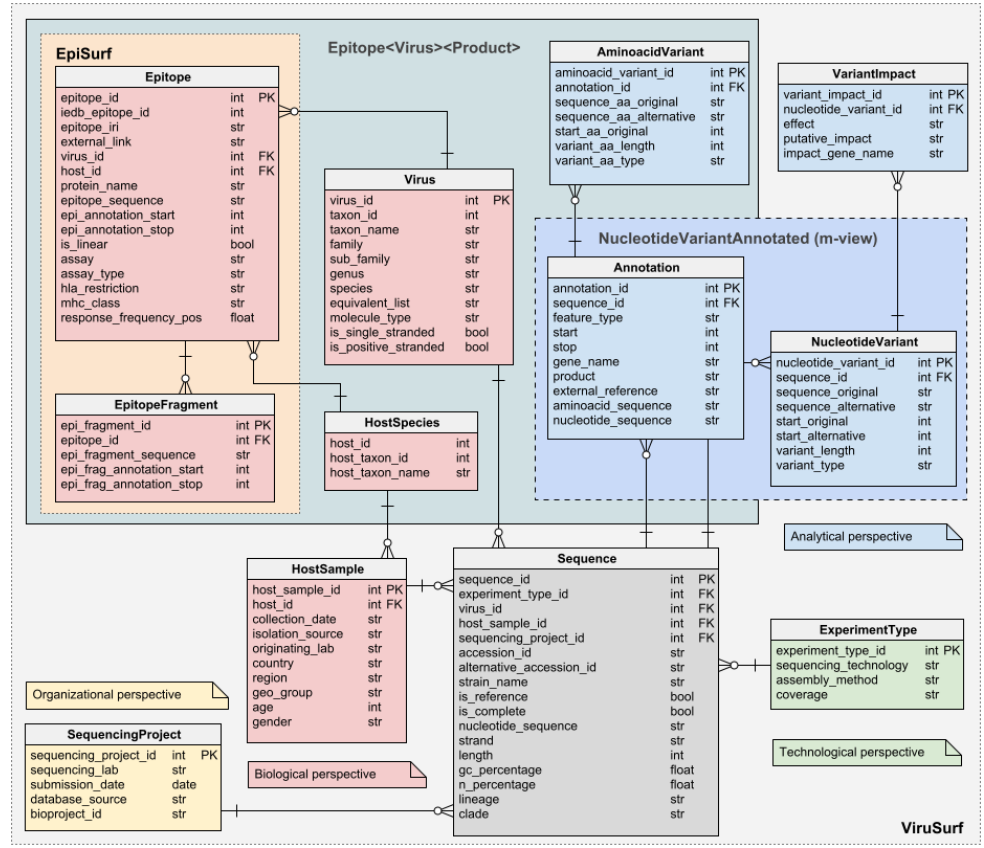
Figure 1. The Viral Conceptual Model (VCM): the central fact S EQUENCE is described by the four different dimensions (biological, technical, organizational, and analytical). The first three are retrieved by the metadata, while the last one (analytical) is computed by processing the sequence through the pipeline. Part of the biological dimension is the two epitopes’ tables (E PITOPE and E PITOPE F RAG - MENT . The schema also anticipates two additional data structures, E PITOPE <V IRUS ><P RODUCT > and N UCLEOTIDE V ARIANT A NNOTATED , which are the subjects of Sections 3.5.3 and